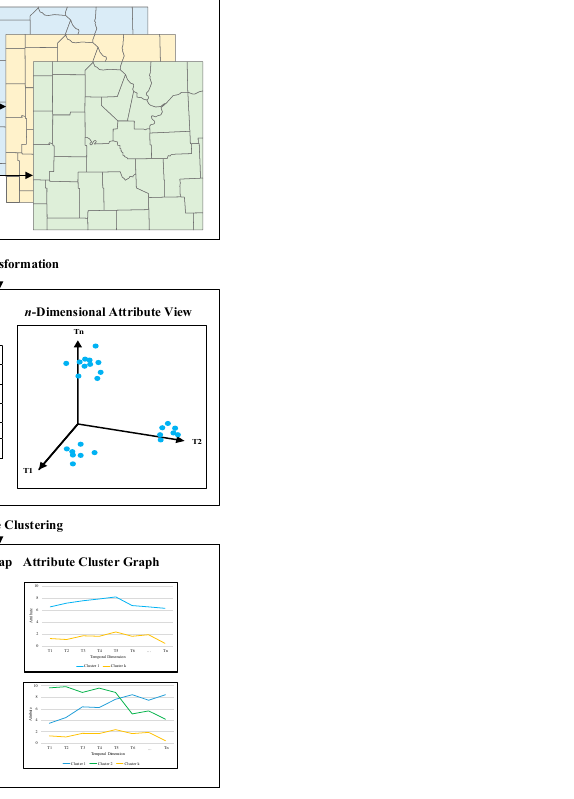
n -Dimensional Attribute View